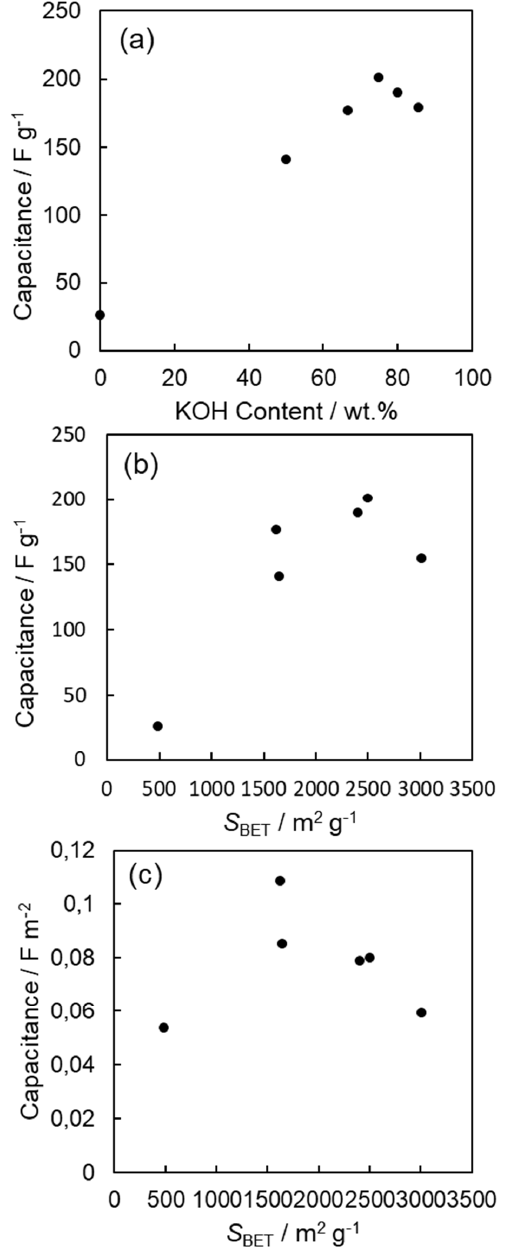
Figure 8. The capacitance values of the samples at 1 mV s − 1 . Capacitance per gram dependence on ( a ) KOH content, ( b ) surface area, and ( c ) capacitance per area dependence on surface area.